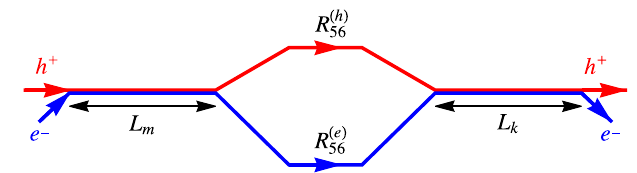
FIG. 1. Schematic of the microbunched electron cooling system. Blue lines show the path of the electron beam, and the red lines indicate the trajectory of the hadron